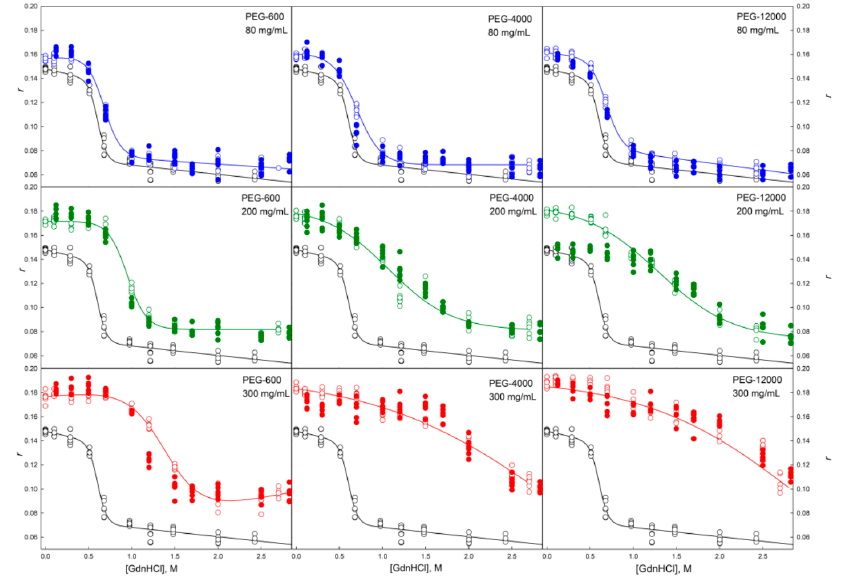
Figure 8. Unfolding/refolding transitions of GGBP in the presence of different concentrations of PEG of different molecular weight recorded by the dependence of the anisotropy of intrinsic fluorescence of GGBP on GdnHCl concentration. The excitation and emission wavelengths were 297 and 365 nm, respectively. Other designations as in Figure 4.